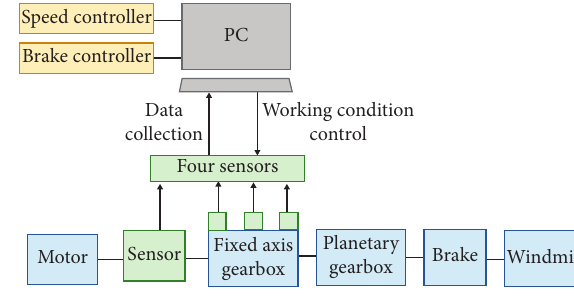
Figure 5: Illustration of WTDS.